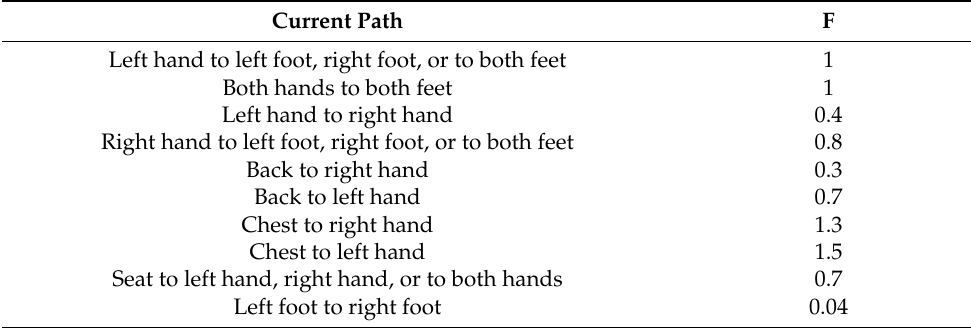
Table 3. Heart-current factor F for different current paths. Current Path F Left hand to left foot, right foot, or to both feet 1 Both hands to both feet 1 Left hand to right hand 0.4 Right hand to left foot, right foot, or to both feet 0.8 Back to right hand 0.3 Back to left hand 0.7 Chest to right hand 1.3 Chest to left hand 1.5 Seat to left hand, right hand, or to both hands 0.7 Left foot to right foot